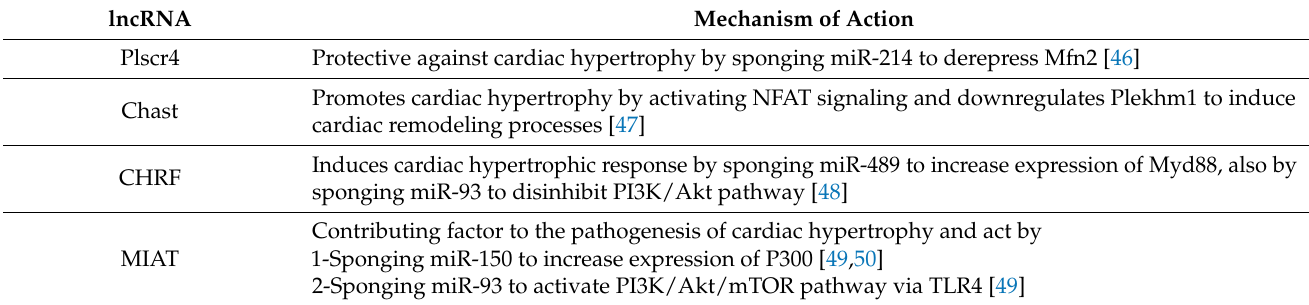
Table 3. LncRNAs involved in pathogenesis of Cardiac